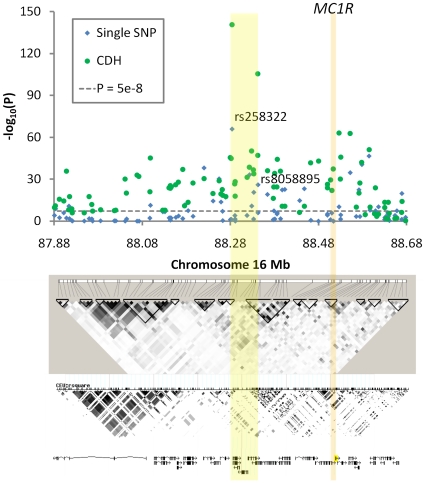
Association between SNPs at MC1R and the red hair color in the Rotterdam Study.The -log10(P) values for association with red hair color were plotted for each genotyped SNP according to its chromosomal position (blue dots) and for the CDH test in each sliding window consisting of 100 SNPs (green dots represent the left-most SNP). The LD patterns in the Rotterdam Study population and in the HapMap CEU samples (release 27) and the known genes in the region were aligned bellow according to the physical position of the SNPs (genome-build version 36.3). The orange bar indicates the physical position of the MC1R gene. The yellow bar indicates the region between two SNPs based on which the most significant P value of the CDH test was obtained (the left-most SNP rs258322 and the right-most SNP rs8058895).